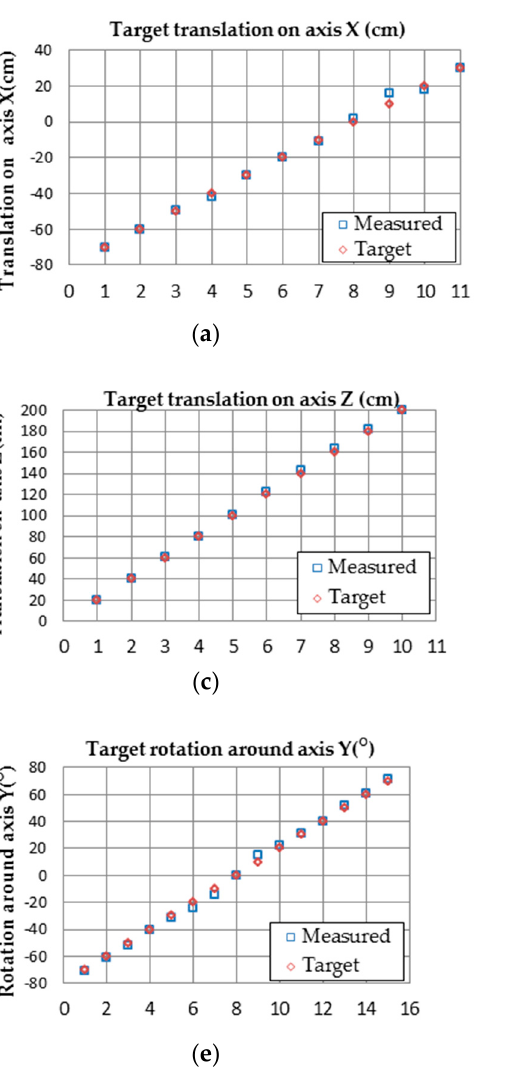
Figure 22. Comparison of pose estimation results. ( a ) Target translation on axis X (cm); ( b ) Target translation on axis Y (cm); ( c ) Target translation on axis Z (cm); ( d ) Target rotation around axis X (°); ( e ) Target rotation around axis Y (°); ( f ) Target rotation around axis Z (°). The minimum, maximum, and mean error of x, y, and z coordinates and roll-yaw-pitch angles are shown in Table 2. Table 2. Relative pose errors of 6-DOF.